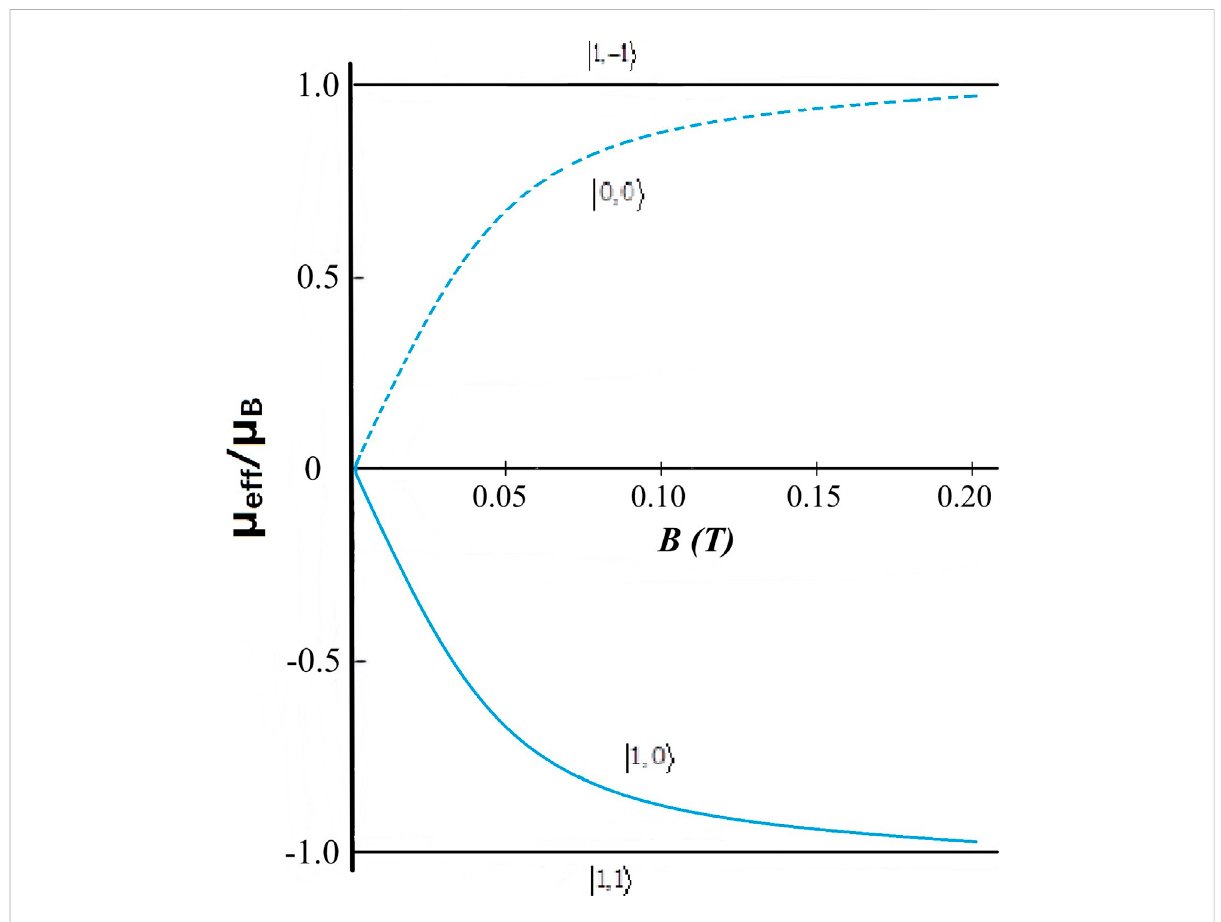
FIGURE 6 Variation of the magnetic moment with the magnetic fi eld.